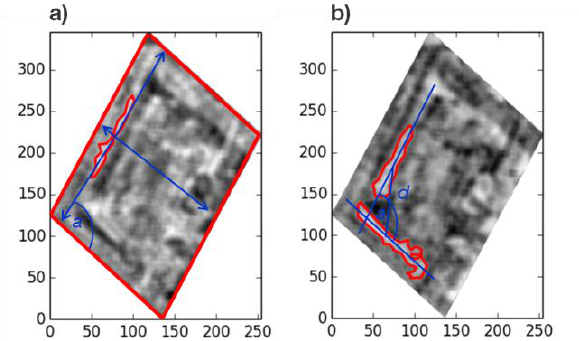
Figure 2. Distance of a CC to the borders of the block (a) and relative distance and orientation between two CCs considered as buildings.